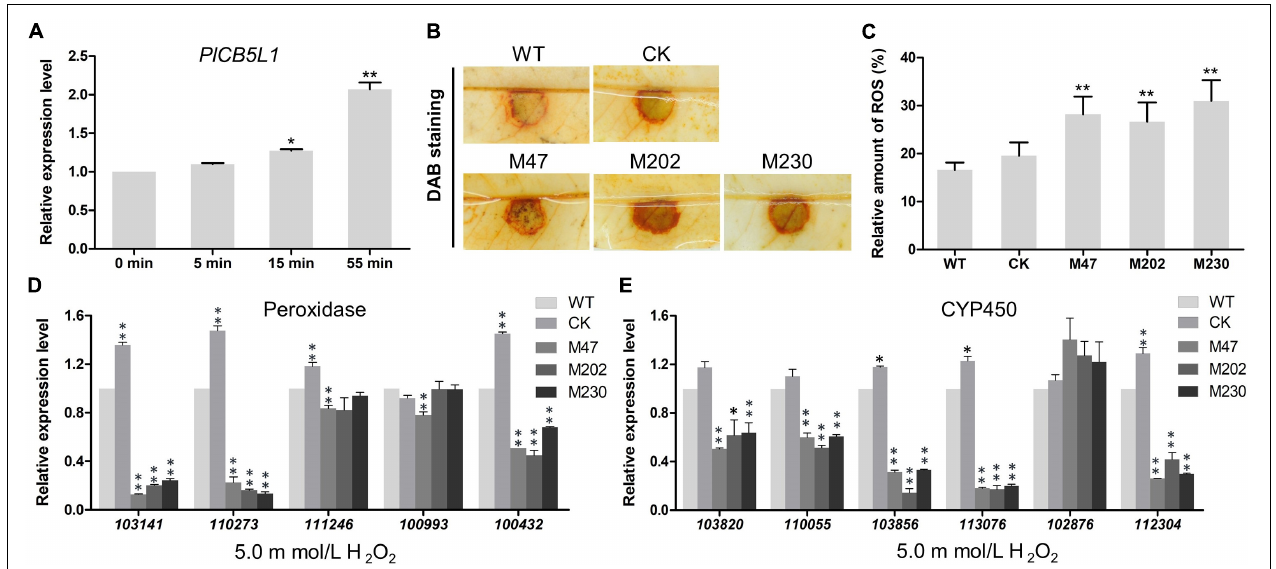
FIGURE 7 | PlCB5L1 is associated with the accumulation of ROS and the expression of peroxidase- and cytochrome P450-encoding genes. (A) Transcriptional analysis of the PlCB5L1 gene during oxidative stress (5 mM H 2 O 2 , for 0, 5, 15, 55 min). Expression levels were normalized using the values at 0 min as “1.” Asterisks represent significant difference, and Data are mean ± SD ( n = 9). (B) ROS accumulation of litchi leaves was detected by DAB staining at 18 h after inoculation. (C) The DAB staining was quantified by ImageJ, which was used to record the grayscale values of all pixels within the brown areas. Data are mean ± SD ( n = 9). (D,E) qRT-PCR analysis of P. litchii putative peroxidase-encoding genes and cytochrome P450-encoding genes in (cid:49) plcb5l1 mutants, CK and WT strain under oxidative stress conditions (5 mM H 2 O 2 , for 5 min). Data are mean ± SD ( n = 9). Asterisks represent significant differences (* p < 0.05 or ** p < 0.01) based on Student’s t -test.